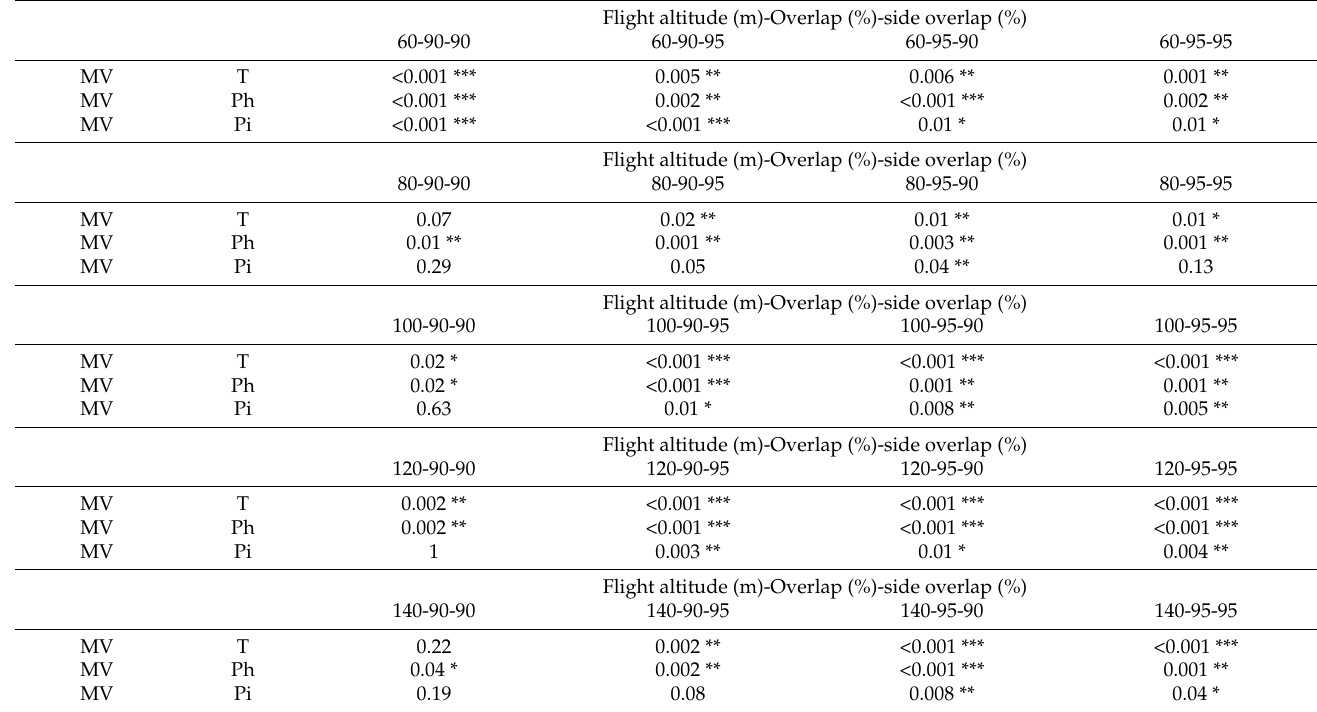
Table 6. Results of multiple comparisons using estimated tree height and measured values for each SfM